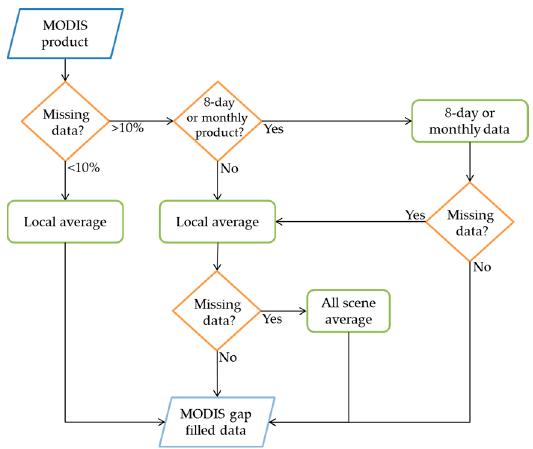
Figure 2. MODIS daily products gap filling procedure. Table 2. MODIS data products level 3 used for the daily products gap filling.